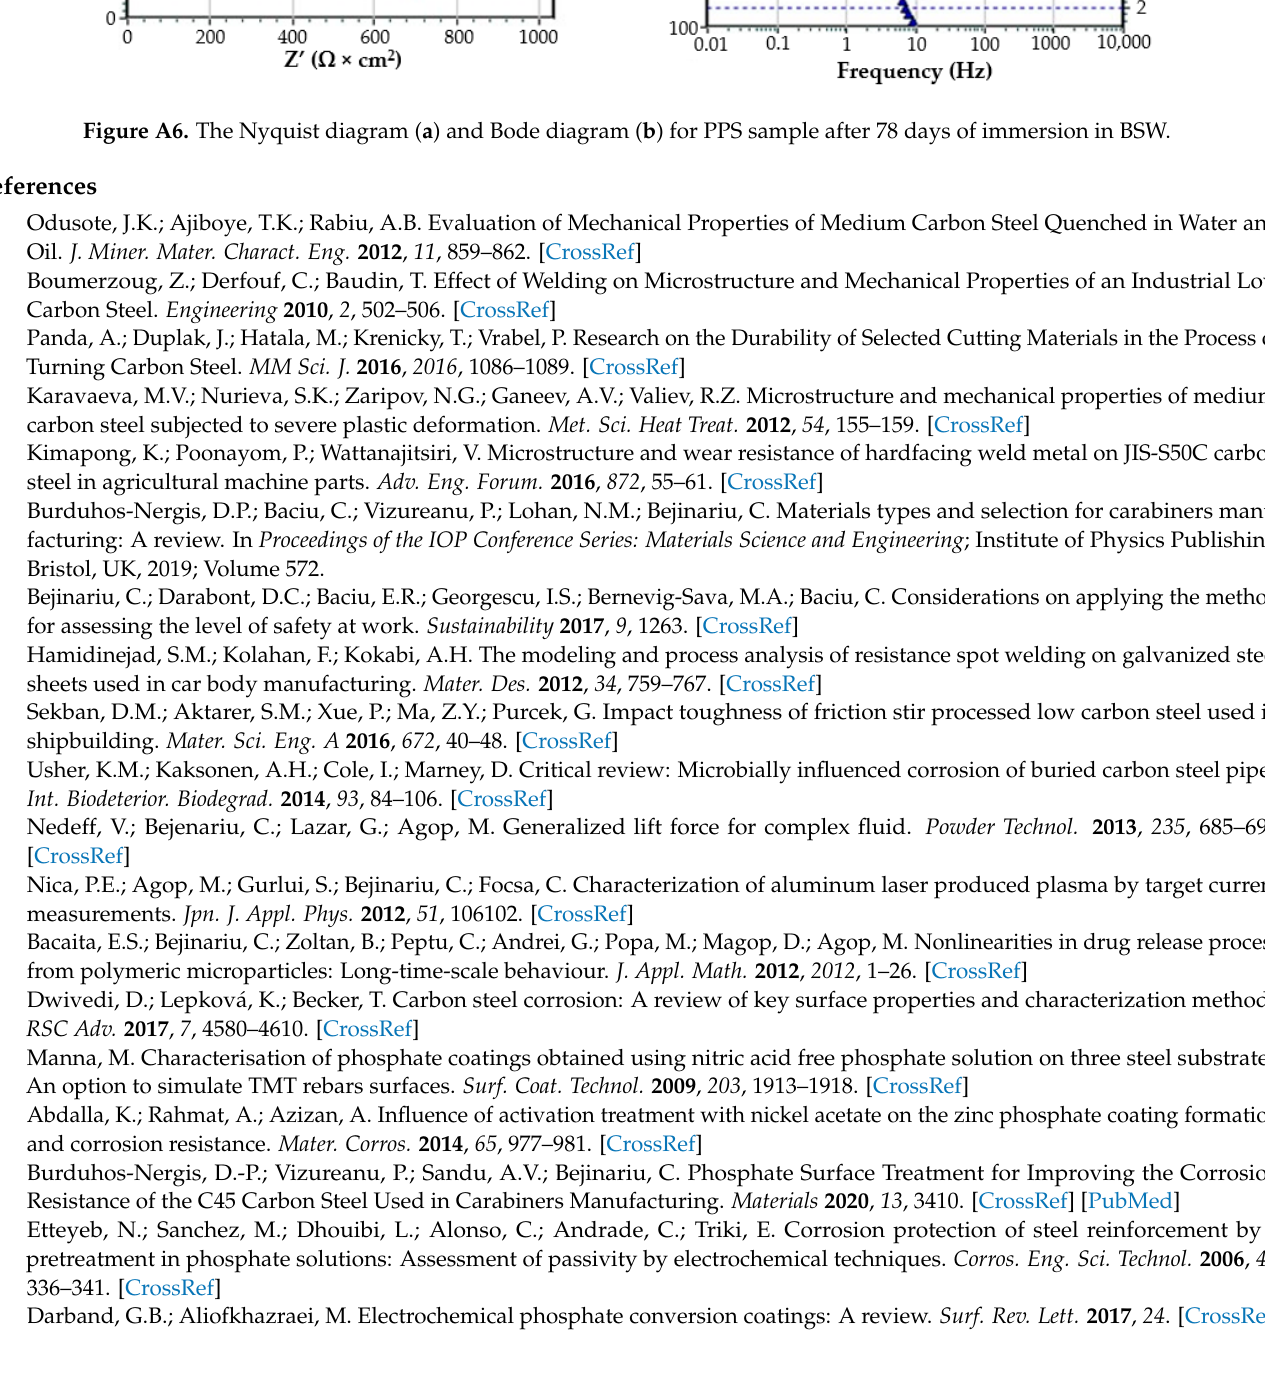
20 of 22 Figure A4. The Nyquist diagram ( a ) and Bode diagram ( b ) for PPS sample after 1 h of immersion in BSW.